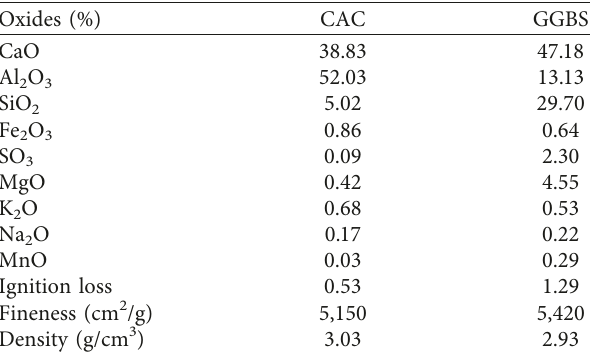
Table 1: Chemical composition of binders used in this